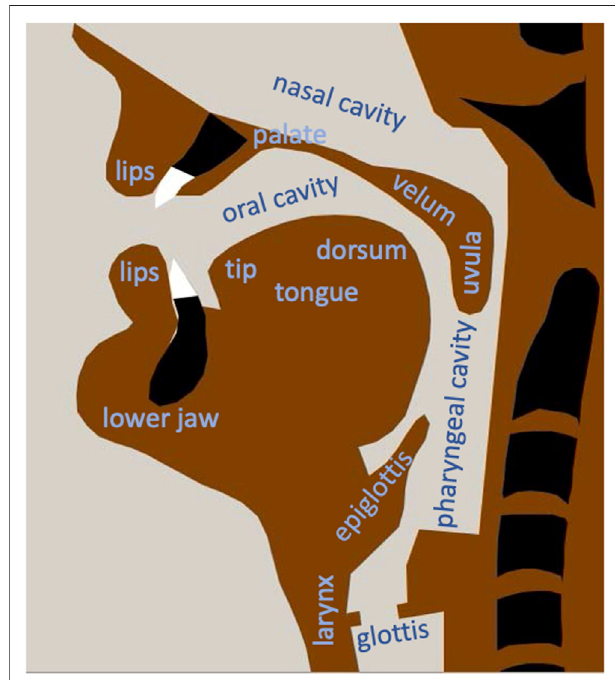
FIGURE 1 | Midsagittal view generated using the two-dimensional articulatory model of Kröger et al. (2014).